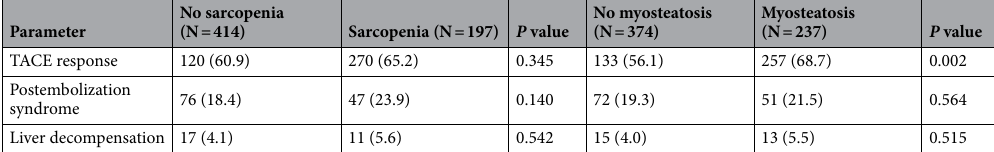
Table 2. TACE response and complication according to myosteatosis or sarcopenia. TACE transarterial chemoembolization.